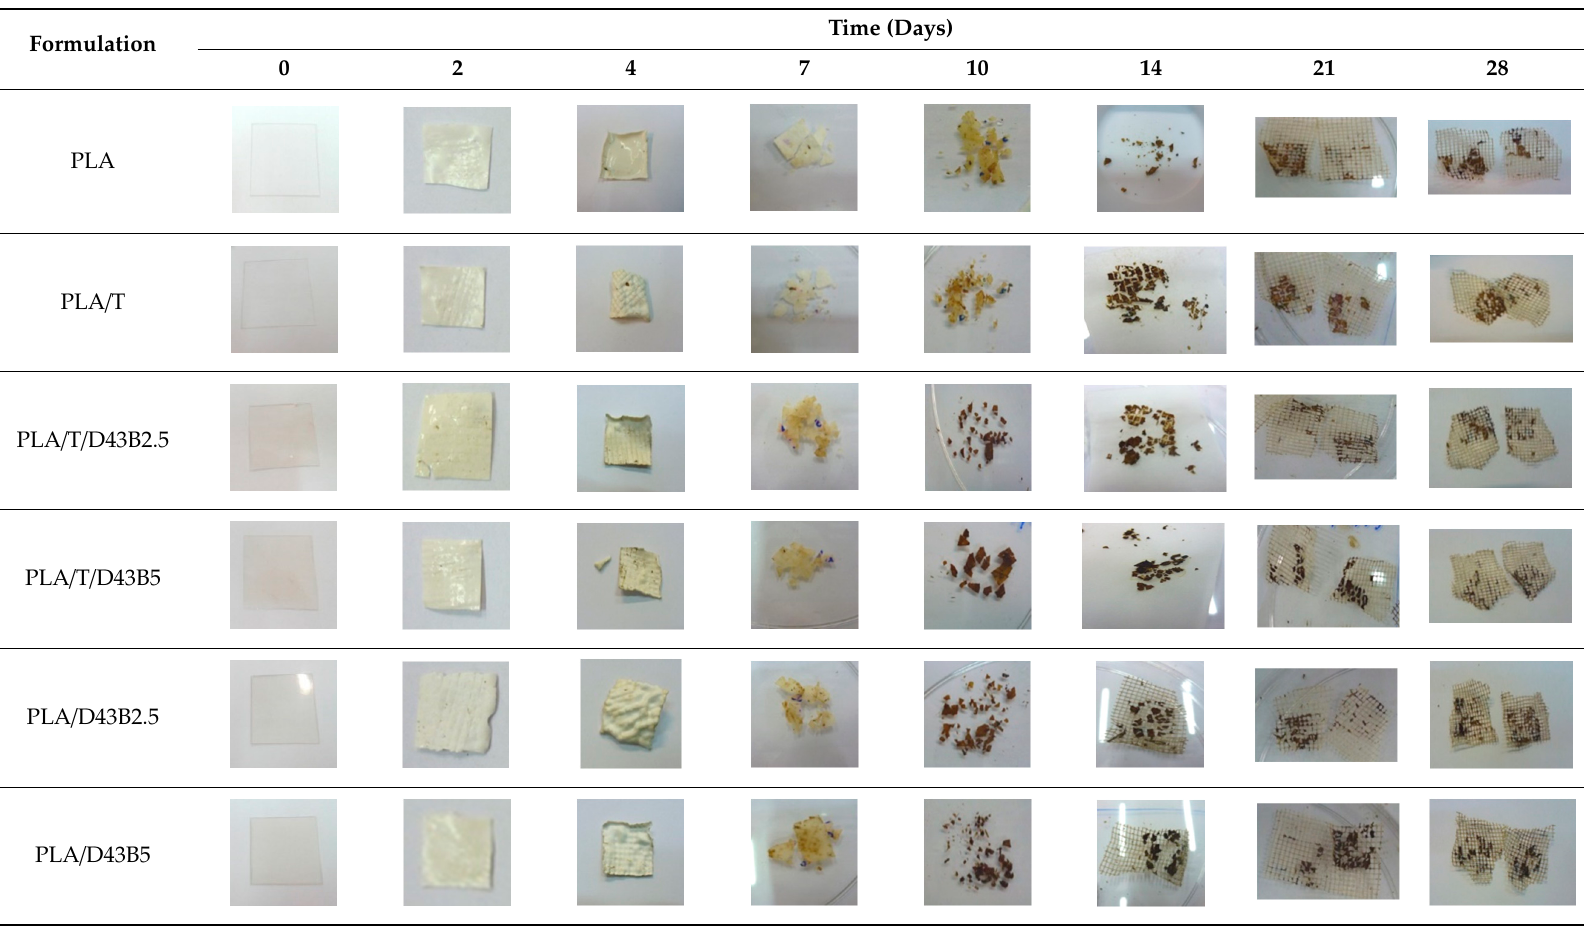
Table 4. Visual appearance of PLA and nano-biocomposite films at different times under composting conditions. Different superscripts within the same column indicate statistically significant different values.